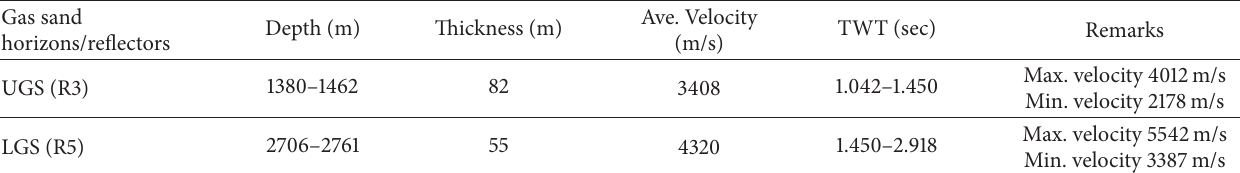
Table 3: Represent average velocity changes with depth of gas sand horizons in the Rashidpur structure.